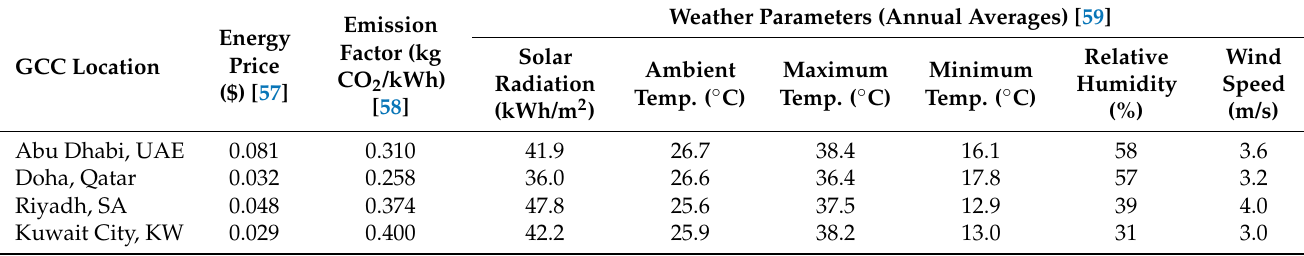
Table 4. Energy cost, emission factor, and metrological parameters for GCC